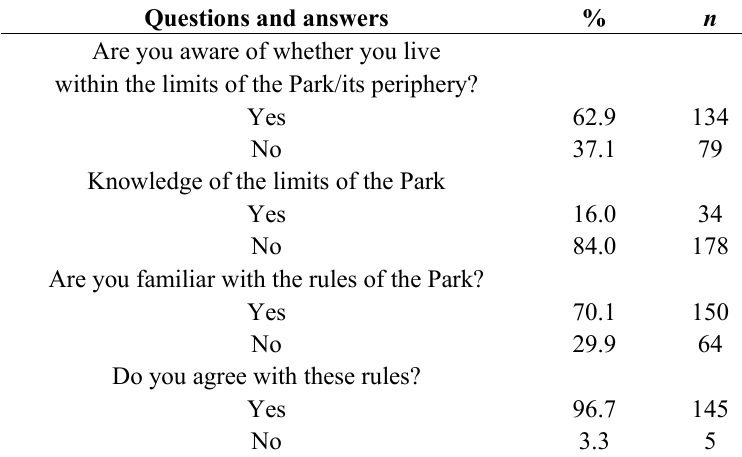
Table 5. Relation between the population and the